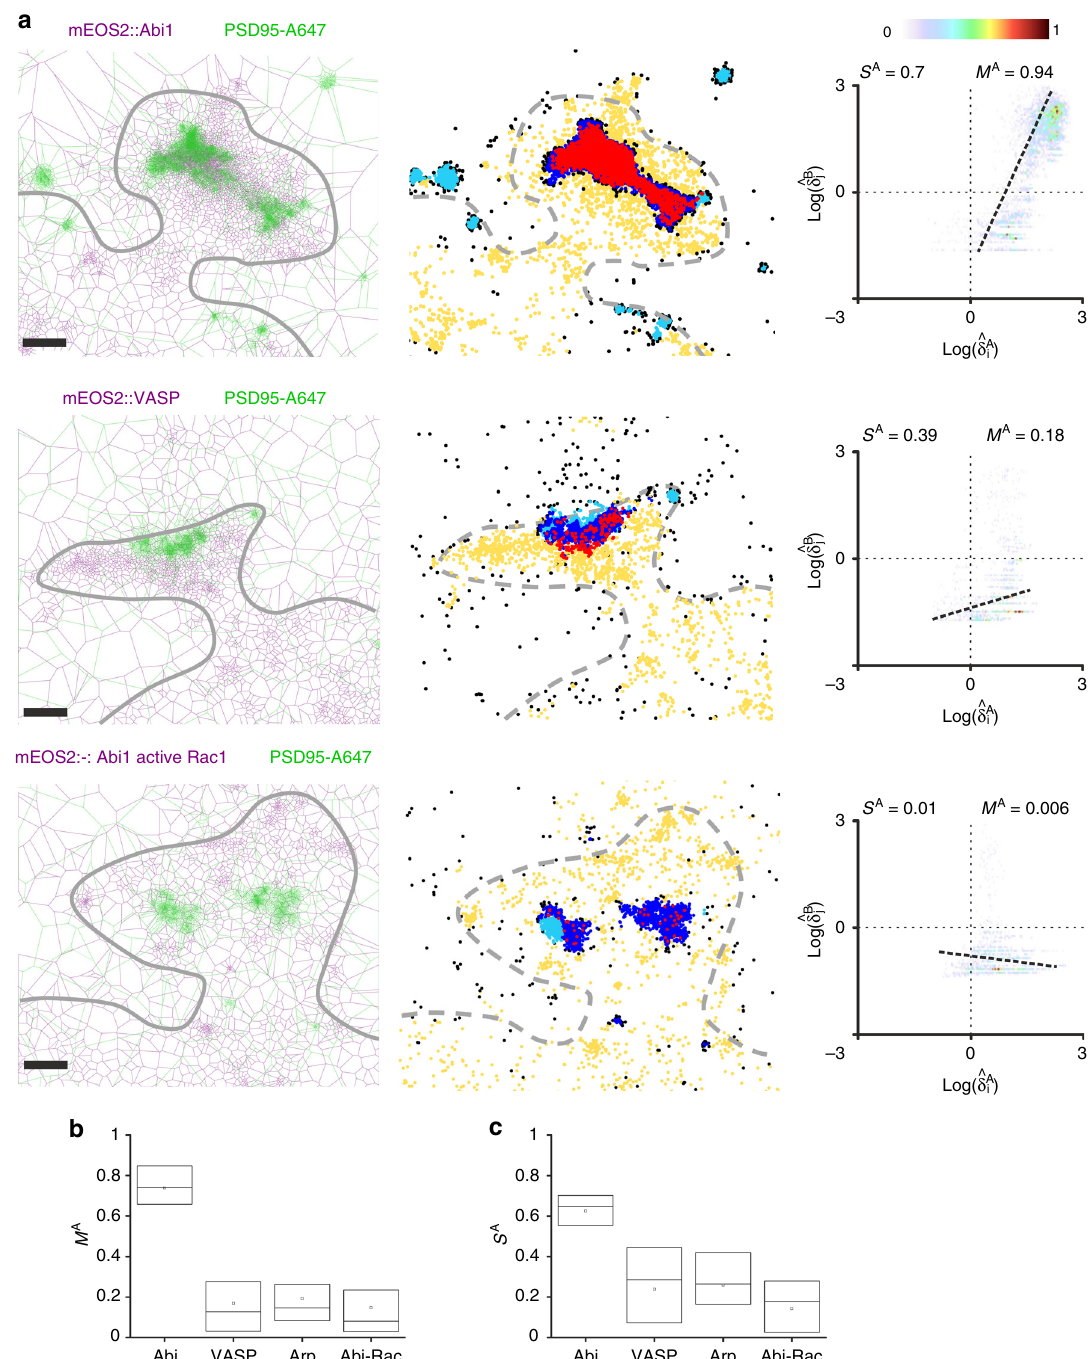
Fig. 4 Voronoï-based colocalization between F-actin regulators and PSD95 in synapses. a Overlay display of the Voronoï diagrams for F-actin regulatory proteins (Abi1, VASP and Abi1 with constitutive Rac1 activation) and PSD95 on 3 different neuronal dendritic spines (left) (scale bar 200 nm). 5 class classi fi cation of the localizations (middle). Manders ’ coef fi cients (M A ) and Spearman rank correlation (S A ) computed from the scatterplots of the F-actin regulatory protein localizations (right). Abi1 protein exhibits a much higher colocalization (M A = 0.85, S A = 0.71) compared to VASP ( M A = 0.2, S A = 0.39) or Abi1 with constitutive Rac1 activation ( M A = 0.01, S A = − 0.25). b Manders ’ coef fi cient computed on selected synapses for the different F-actin regulatory proteins (Abi1: M A = 0.74 ± 0.02 SEM; VASP: M A = 0.17 ± 0.02 SEM; ArpC5A: M A = 0.19 ± 0.03 SEM; Abi1 with constitutive Rac1 activation: M A = 0.15 ± 0.04 SEM). c Spearman rank correlation computed on the same synapses (Abi1: S A = 0.62 ± 0.02 SEM; VASP: S A = 0.24 ± 0.03 SEM; ArpC5A: S A = 0.26 ± 0.03 SEM; Abi1 with constitutive Rac1 activation: S A = 0.14 ± 0.04 SEM. In all box plots the center line is the median, the square is the mean and the bounds of the boxes are the 75 and 25% percentiles i.e., the interquartile range